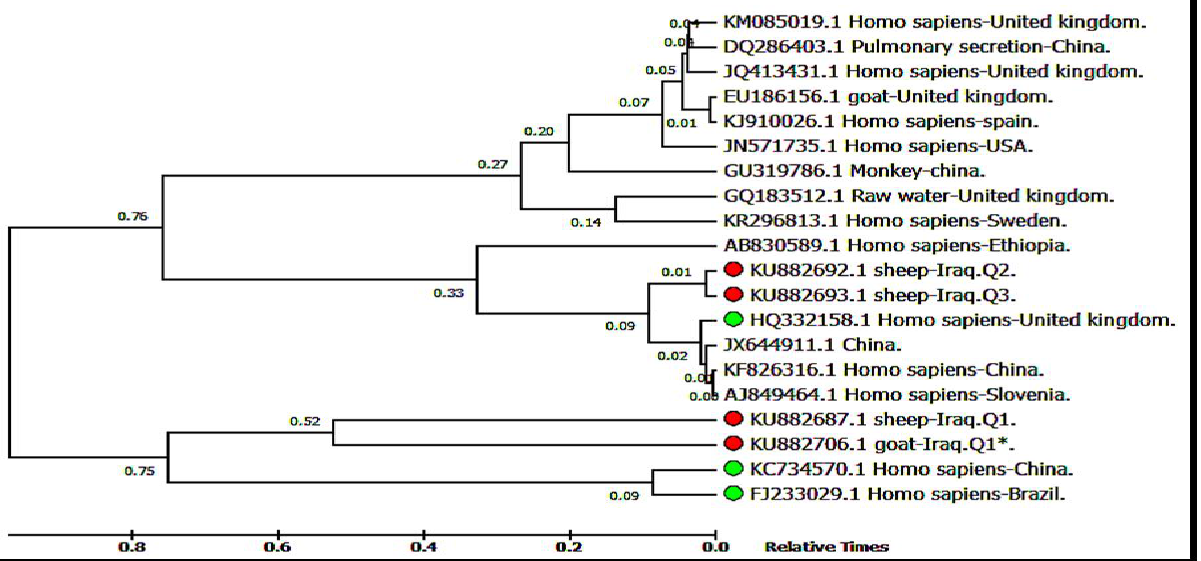
Figure, 4: Phylogenetic tree using the Neighbor joining method. The evolutionary distances analyses were conducted in MEGA6.*Red spot: C. hominis strain isolated from Iraq.*Green spot: Strain high homologous with Iraqi – C. hominis isolated from sheep 1*, 2*.